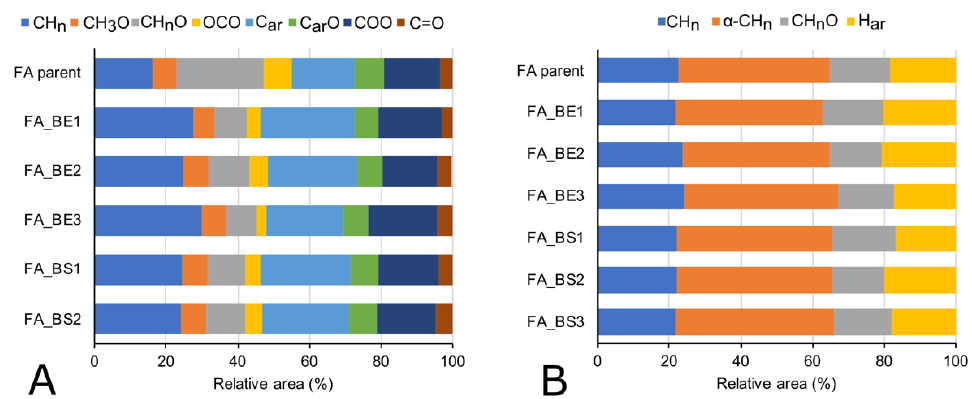
Figure 7. Distribution of integral intensities of C atoms ( A ) and H atoms ( B ) in the specified chemical environments (shown in the upper row of the Figure) in the parent FA and the FA isolates obtained with a use of the Bond Elut PPL sorbent (FA_BE) and Bondesil PPL sorbent (FA_BS). The data are measured by 13 C NMR ( A ) and 1 H NMR ( B ) spectroscopy.